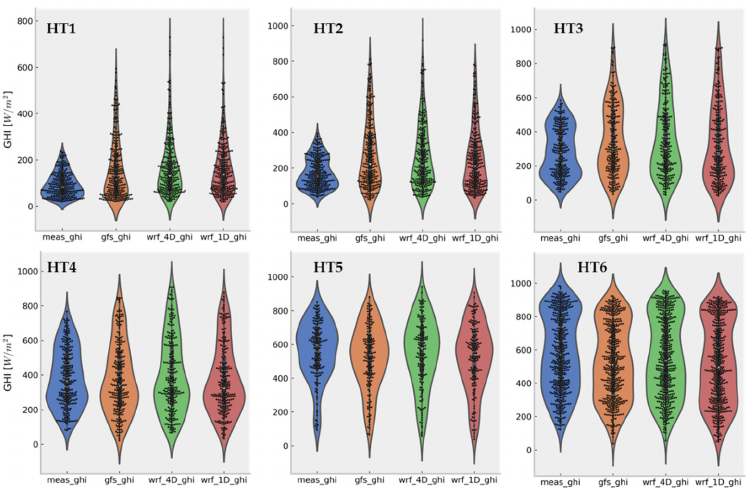
Figure 2. Violin swarm plots of ground measurement data with GFS, WRF solar 4 domains and 1 domain.